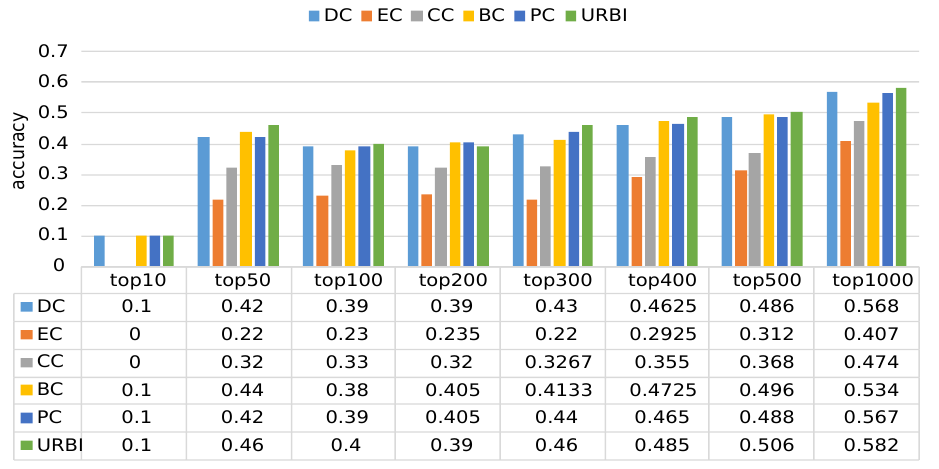
Figure 4. This figure depicts the experimental results of dataset No.4, which contains 6818 book nodes.